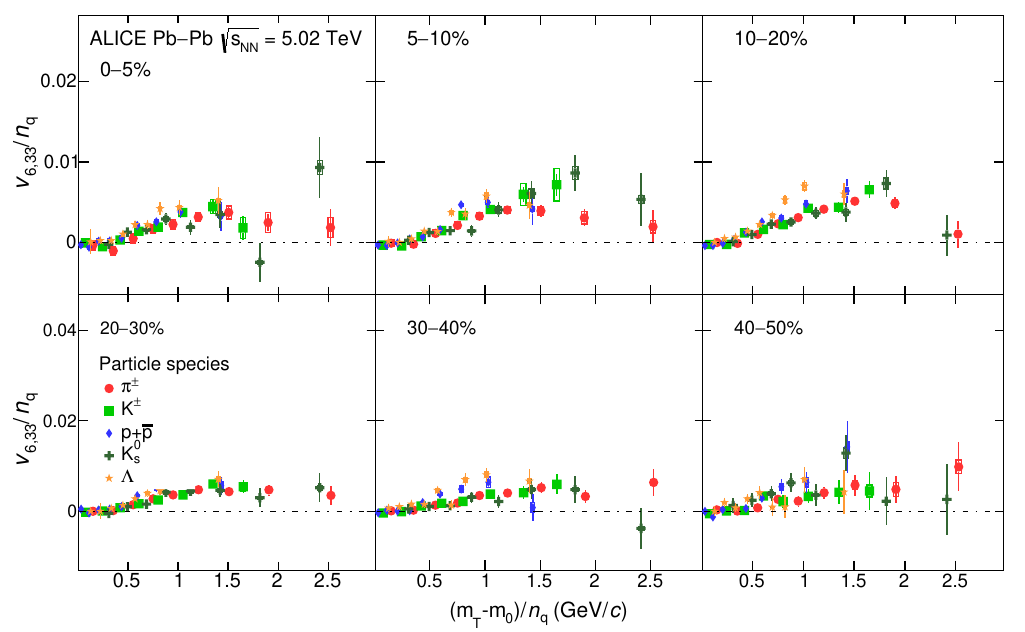
Figure 24 . The ( m T (cid:0) m 0 ) =n q -dependence of v 6 ; 33 =n q for di(cid:11)erent particle species grouped into p di(cid:11)erent centrality intervals of Pb-Pb collisions s NN = 5 : 02 TeV. Statistical and systematic un- certainties are shown as bars and boxes, respectively. It is seen that the KE T scaling holds for v 6 ; 33 at an approximate